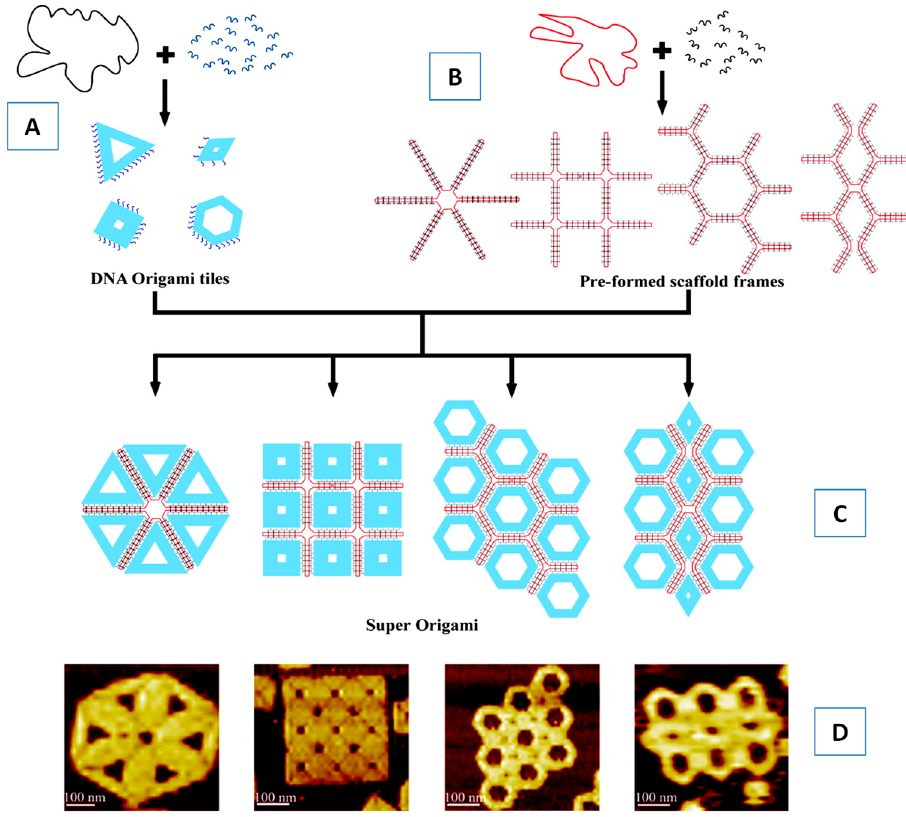
Figure 16. Mechanism of formation of superorigami. Initially, single stranded DNA scaffold (black circular strand) is pre-folded by a set of short DNA staples (blue bridge strands) to form various shapes of DNA origami tiles, ( A ). Moreover, some DNA scaffolds (red circular strand) are folded by a set of bridge strands (black strands) to form some tailored frameworks (preformed scaffold frames) ( B ). Finally, the preformed DNA origami tiles (that displays a group of single-stranded extensions, used as sticky points) are able to interact with the preformed scaffold frames to create the various super-origami structures ( C , D ). Adapted with permission from Reference [187]. Copyright (2011) American Chemical Society.